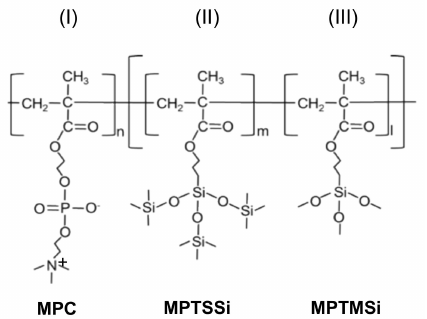
Figure 1. Structure of the copolymer used as substrate. The three functional moieties are ( I ) a phospholipid-like unit 2-methacryloyloxyethyl phosphorylcholine (MPC), ( II ) a hydrophobic unit 3-(methacryloyloxy) propyl-tris(trimethylsilyloxy) silane (MPTSSi) and ( III ) a substrate bonding